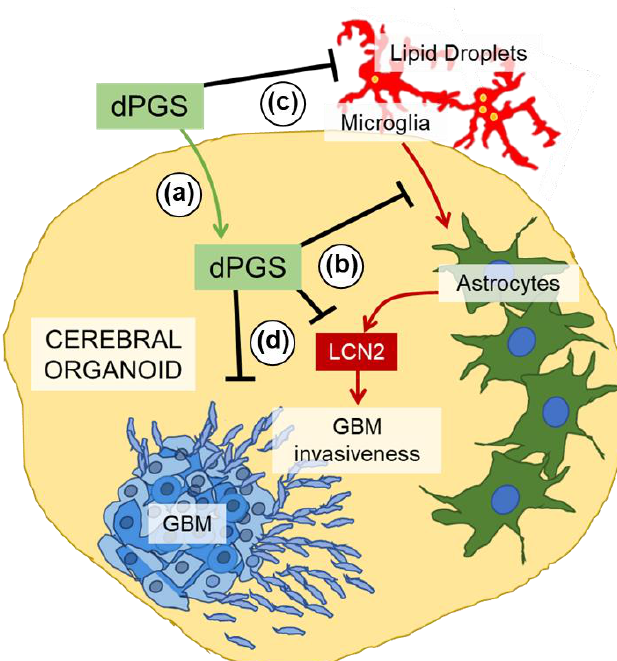
Figure 4. Schematic representation of the proposed modulatory effects of dPGS on microglia, astrocyte and glioblastoma crosstalk. ( a ) dPGS is internalized in cerebral organoids, and ( b ) downregulates LCN2 produced by microglia-induced astrocytes, thereby ( c ) reducing markers of inflammation (e.g., lipid droplets) and ( d ) glioblastoma invasiveness.